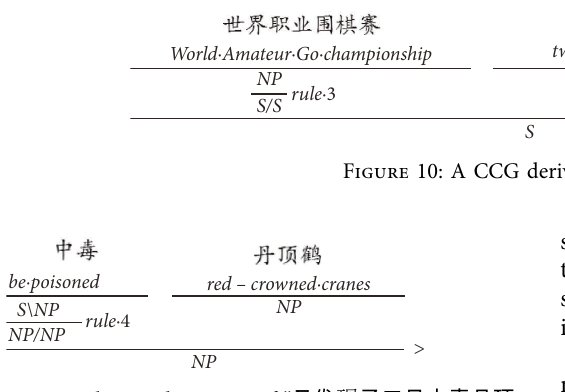
Figure 11: A partial CCG derivation of “ 又发 现 了三只中毒丹顶 鹤 ” (find three more poisoned red-crowned cranes) with rule 4. Table 5: NVN parsing process in